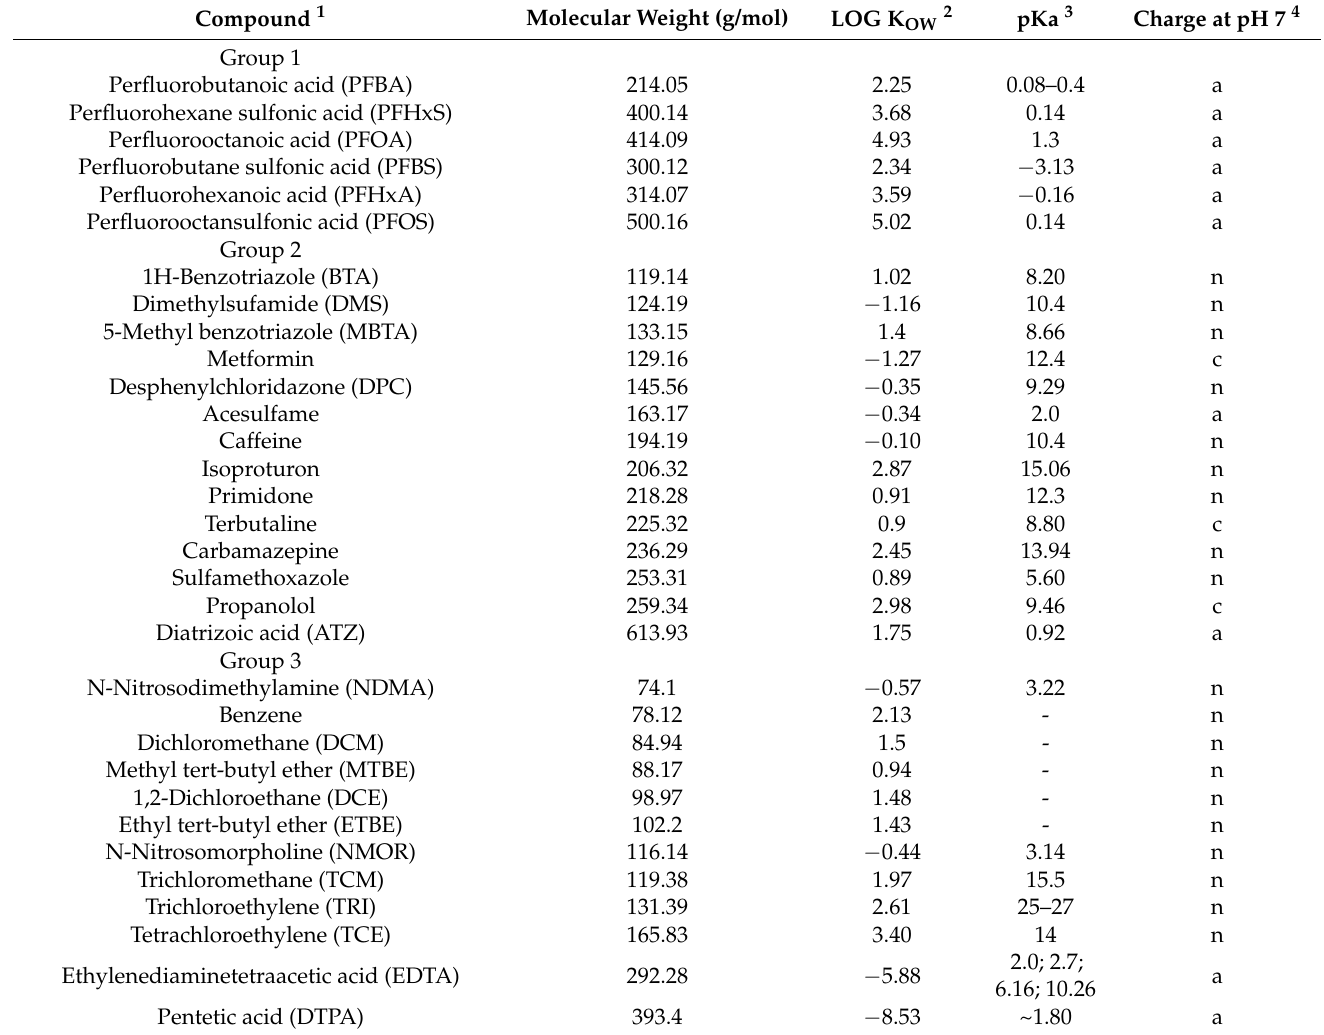
Table 1. List of TrOCs investigated in this work and their physicochemical